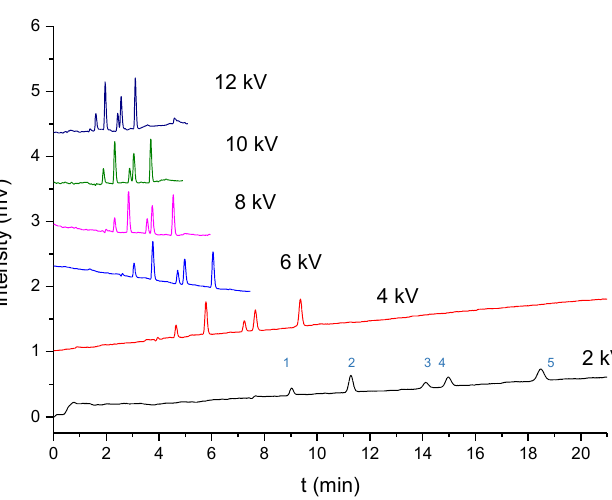
Figure 5. The pCEC separation of 5 estrogens at voltages of 2 kV to 12 kV in the columns packed with 300 nm particles. The experimental conditions were as follows: column: 100 µ m i.d. × 100/300 mm (effective/total length); pressure = 15.5 MPa; mobile phase: acetonitrile—10 mM phosphate butter (60:30, v / v ); pH = 7.8; and split ratios of 800:1. The peaks correspond to the following: (1) E3; (2) BPA; (3) E2; (4) E1; and (5) HE.